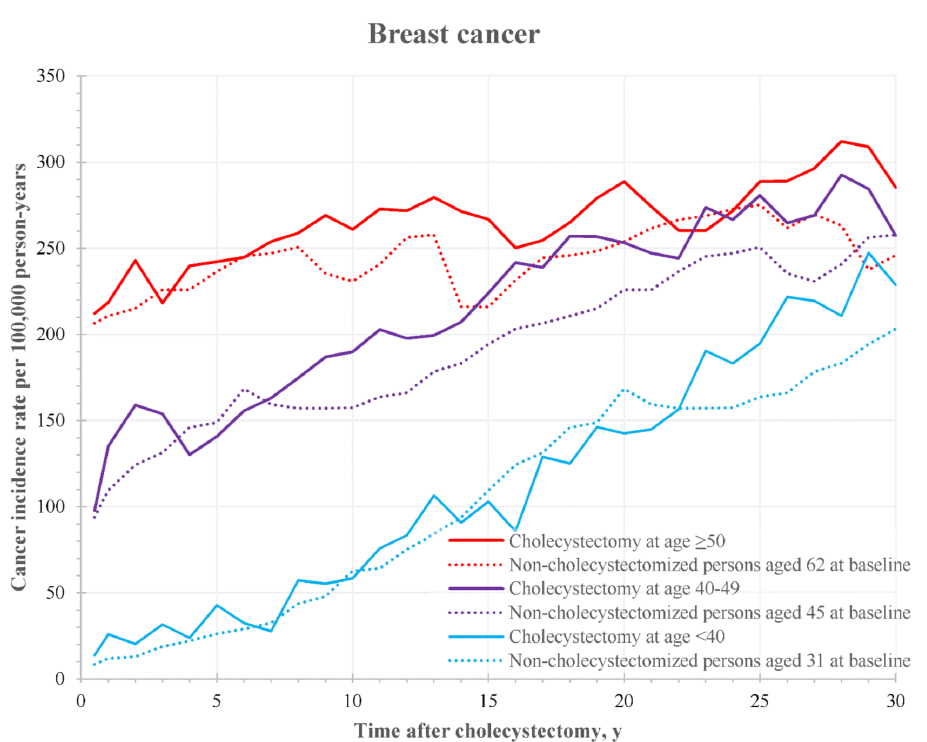
Figure 2. Incidence rate of breast cancer after cholecystectomy by time after surgery and patient’s age at the operation. Dotted lines represent the corresponding rates for non-cholecystectomized individuals with an age at baseline equal to the median age in the groups of cholecystectomized patients.